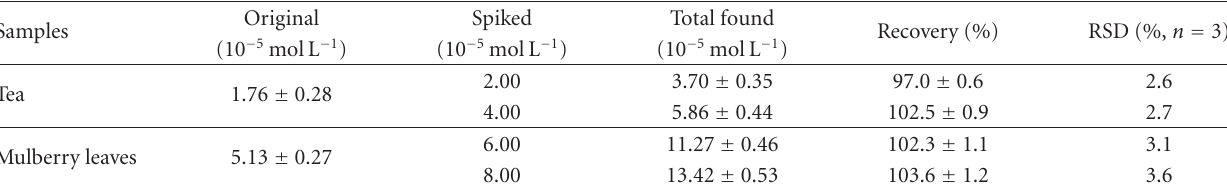
Figure 5: The amperometric current response with increasing concentrations of morin. Δ E of 0.6V was applied. Sample volume was 200 μ L with the flow rate of 30 μ Ls − 1 . Table 1: Sequential injection lab-on-valve format hyphenated with amperometry based on PVP/CPE with applications to the analysis of morin in real samples a